Question: Does the plotted quantity increase or decrease?
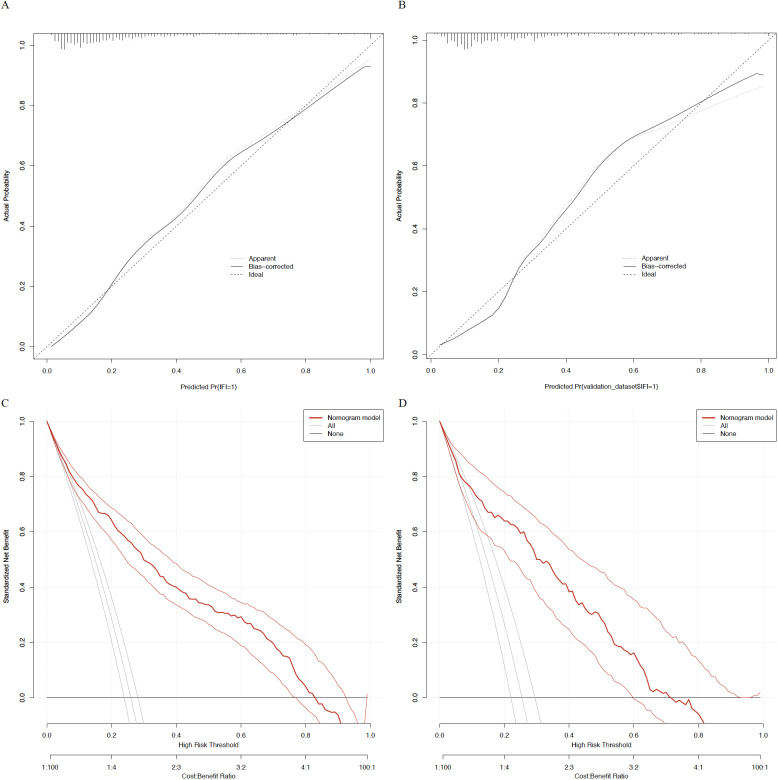
Answer: increasing